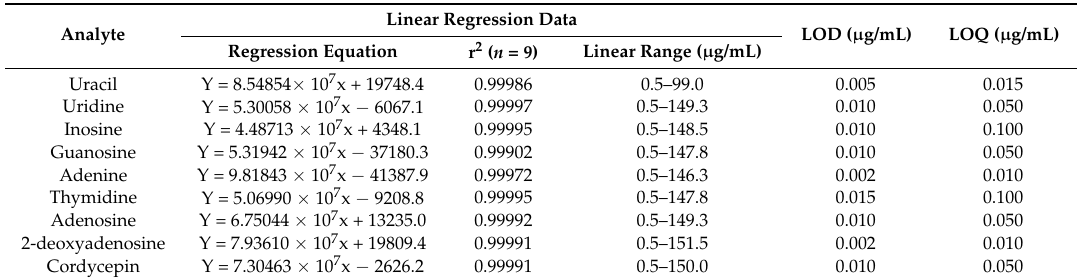
Table 1. Linear regression data, limit of detection (LOD), limit of quantification (LOQ) for nine analytes by HPLC.